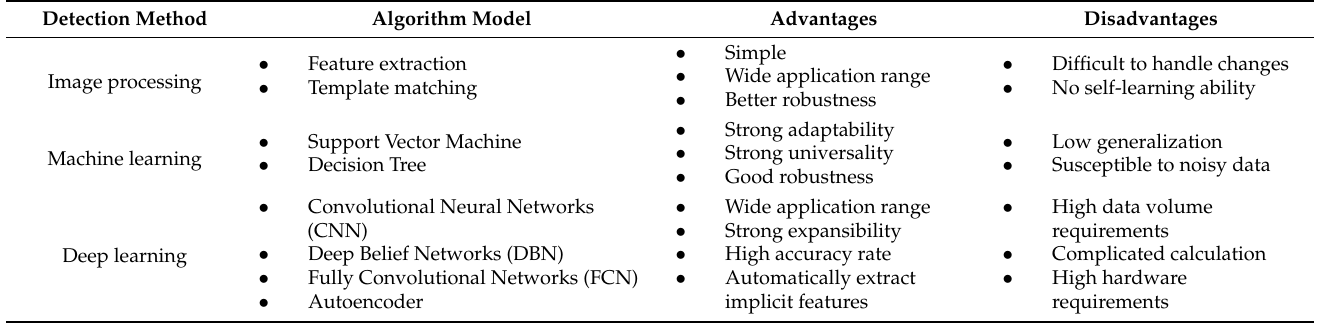
Table 3. Comparative analysis results of some commonly used defect recognition algorithms based on